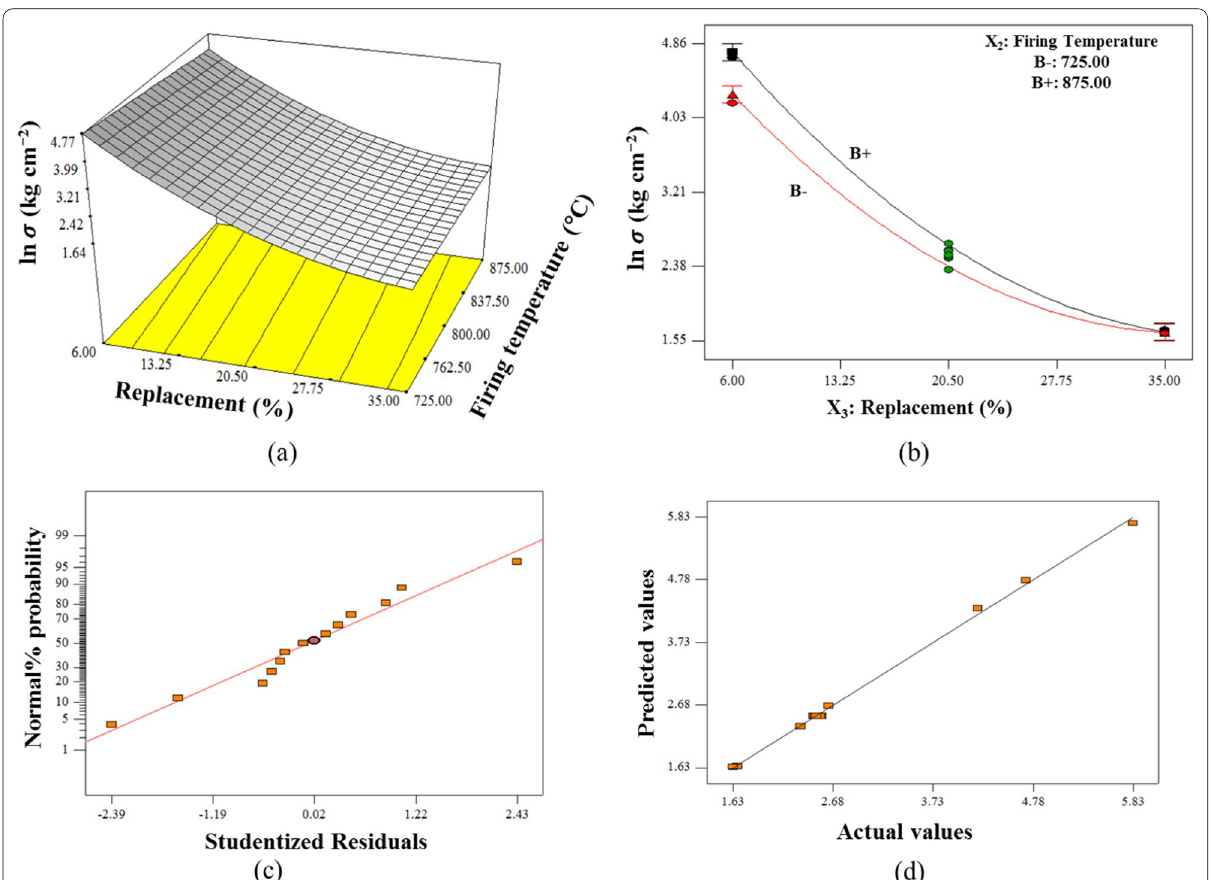
Fig. 7 Clay‑PA fired bricks: a model three‑dimensional (3D) graph, b model contours, c normal plot of the residuals, and d actual values of the response versus the predicted values